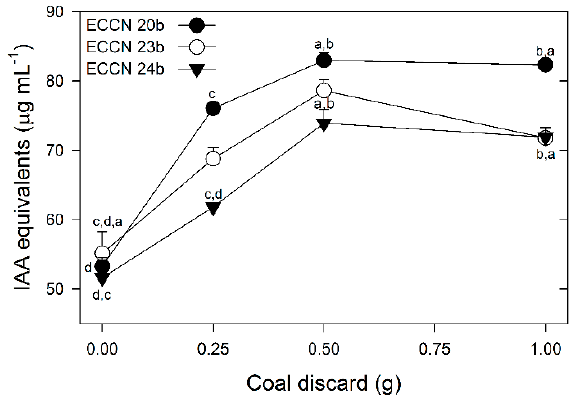
Figure 4. Effect of coal discard on formation of indolic compounds by cultures of Proteus ECCN 20b, Proteus ECCN 23b and Serratia ECCN 24b in response to L-trp supplementation. Results are from three experiments and expressed as the mean ± S.E. Means denoted by a different letter indicate significant differences within treatments ( p < 0.05).